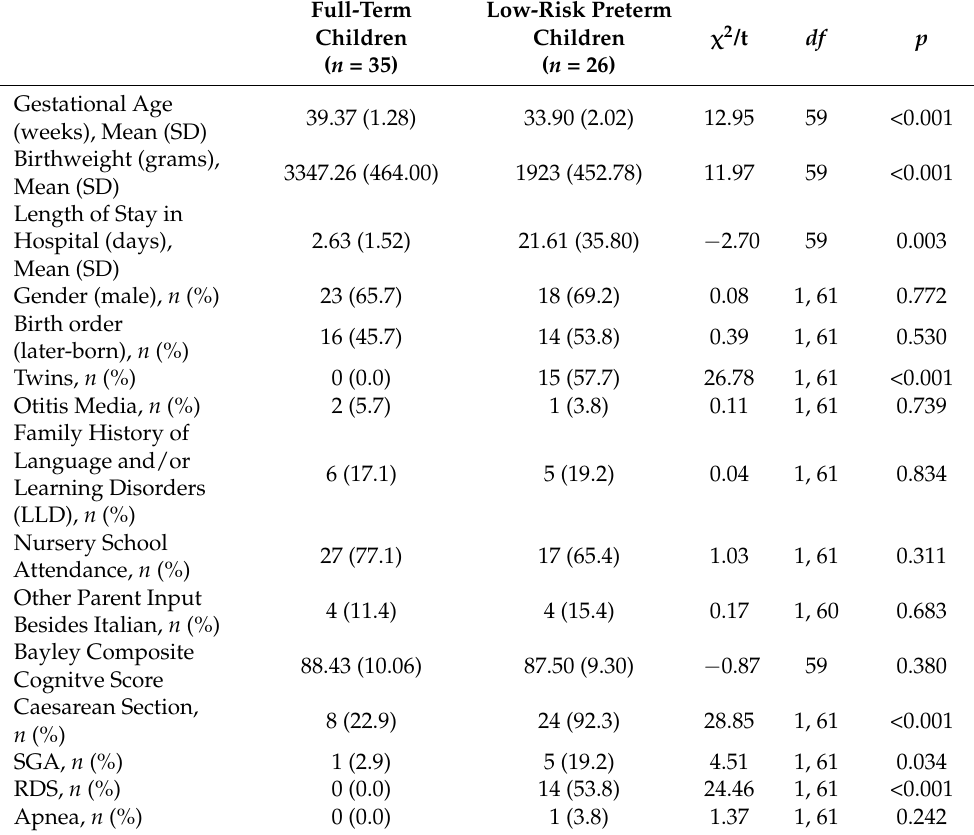
Table A1. Full-term and low-risk preterm participants’ biological, clinical, and socio-demographic